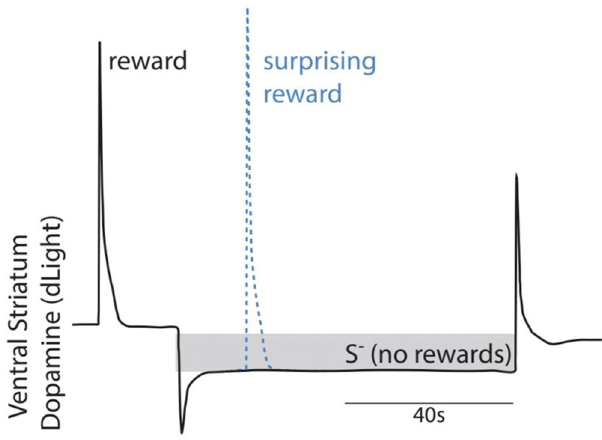
Fig. 7 Graphical summary of results. In the ventral striatum abrupt transitions in reward availability states evoke signed dopamine transients. Dopamine tone is persistently lower in periods when rewards are unavailable (S-, no rewards), compared to when they are available. When surprising rewards are delivered in the non-rewarding period, the reward- evoked dopamine transients are larger, even though they arise during a lower background level of